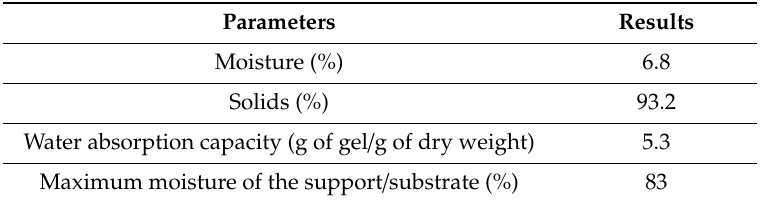
Table 2. Data obtained about water absorption capacity of Castilla Rose (in dry